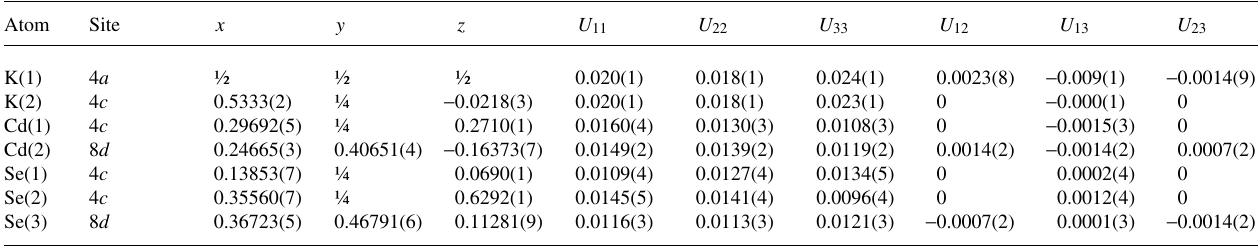
Table 2. Atomic coordinates and displacement parameters (in Å 2 )